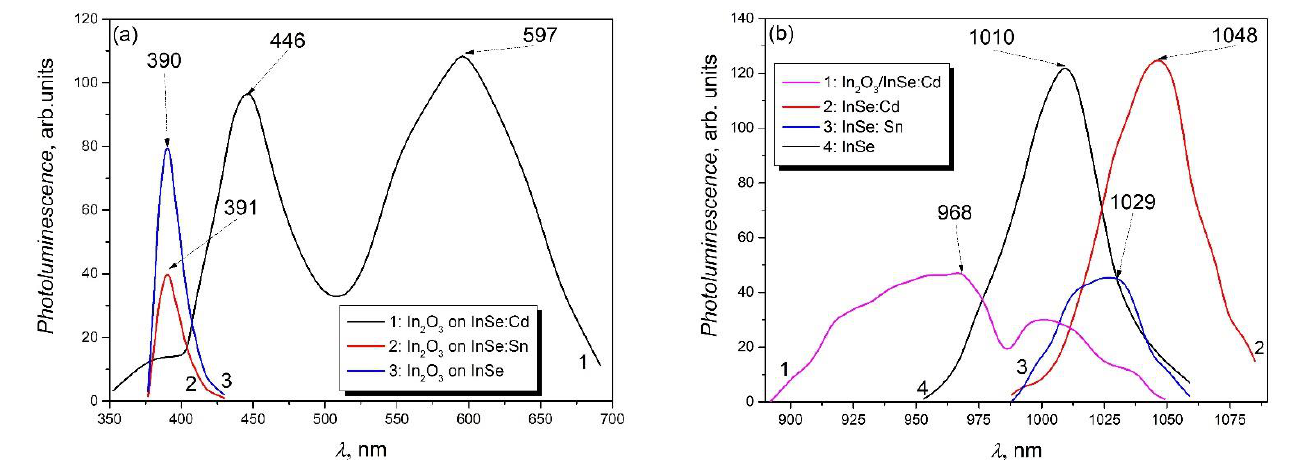
Figure 4. ( a ) Photoluminescence of In 2 O 3 layers on InSe:Cd (curve 1), InSe:Sn (curve 2), and un- doped InSe (curve 3) substrates. ( b ) PL spectra of the material formed on the InSe plate, from the InSe:Cd/In 2 O 3 interface (curve 1), of InSe:Cd (curve 2), InSe:Sn (curve 3), and undoped InSe (curve 4) single